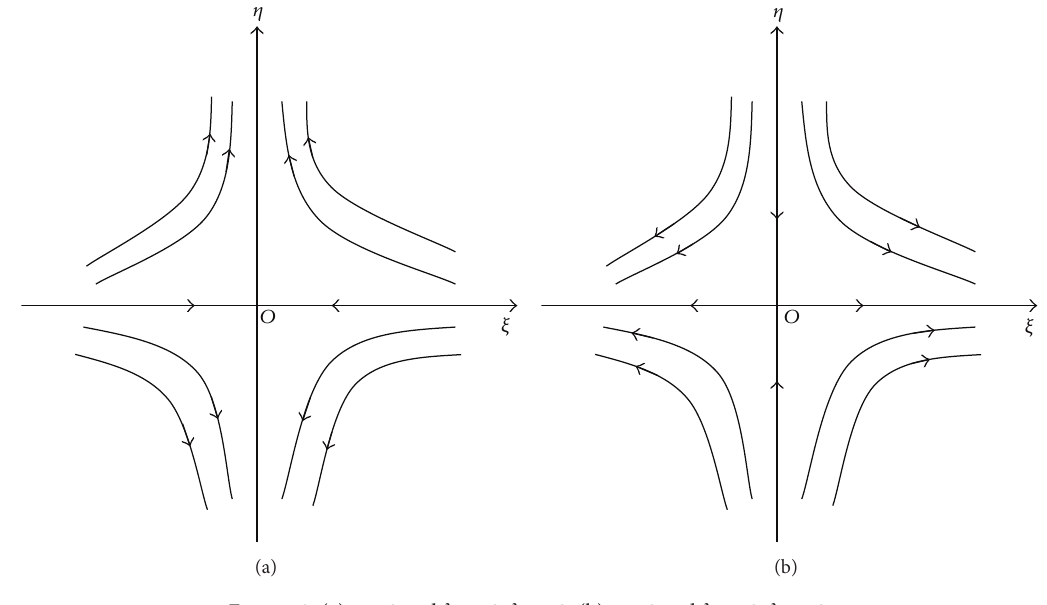
Figure 3: (a) 𝑞 < 0 and 𝜆 1 < 0 , 𝜆 2 > 0. (b) 𝑞 < 0 and 𝜆 1 > 0 ,𝜆 2 < 0.